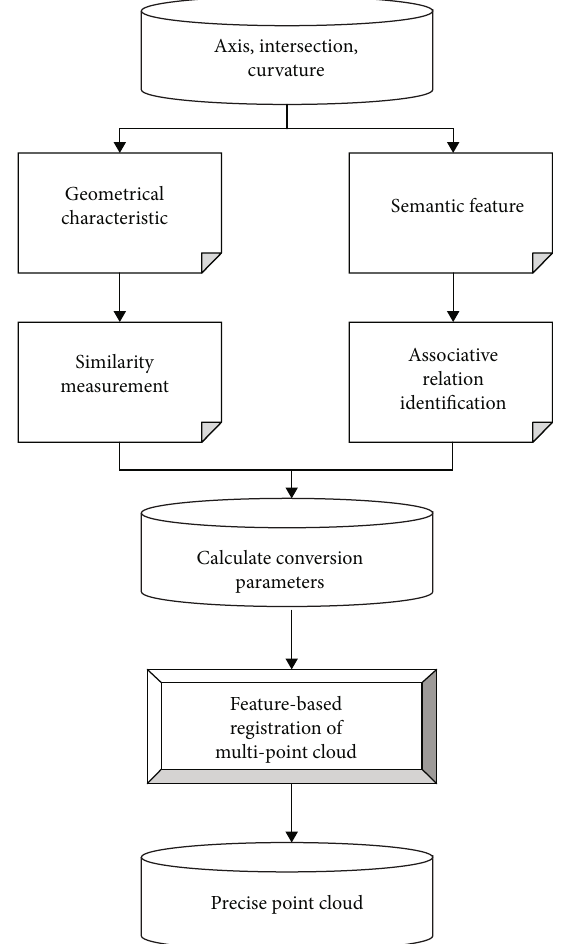
Figure 1: Multisource data point cloud data registration